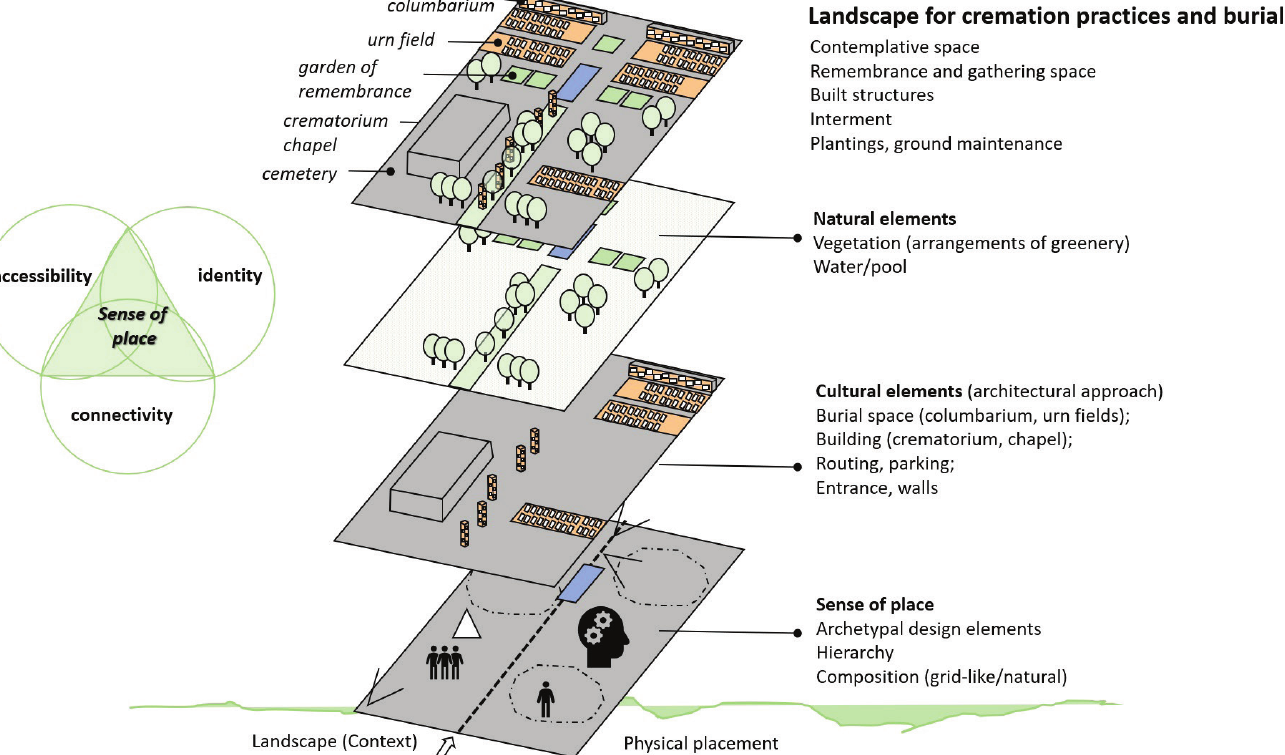
Figure 5. Layers of landscape for cremation practices and burial as a basis for identification of design solutions („pattern book“). Own